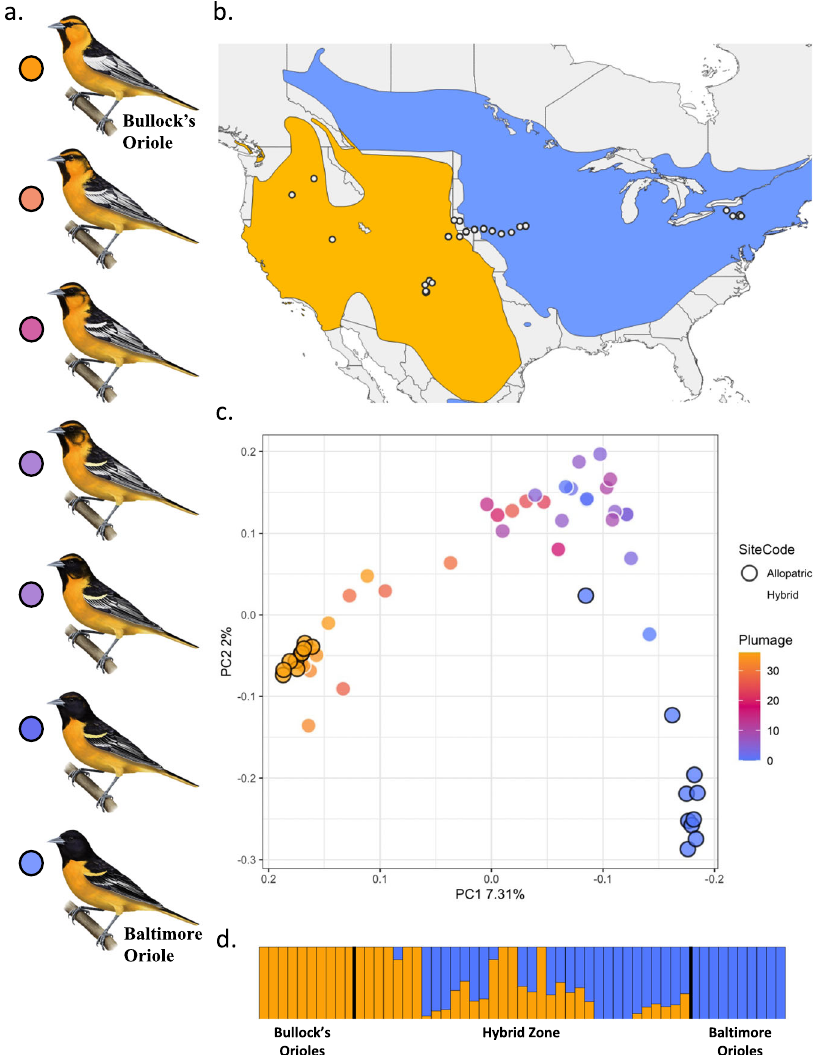
Fig. 1 Geographic, phenotypic, and genomic variation in Baltimore and Bullock ’ s orioles. a An example of the phenotypic gradient observed in the two species and their hybrids. Phenotypically pure Baltimore Orioles are in blue and phenotypically pure Bullock ’ s Orioles are in orange. Illustrations by Megan Bishop, 2019. This image is the property of Cornell University. b Sampling locations for the individuals sequenced for this study. The range of both the Bullock ’ s (orange) and the Baltimore (blue) oriole is shaded on the map. c PCA of 55 resequenced individuals based on 11.6 million SNPs. Individuals are colored by plumage score. Black circles indicate individuals sampled outside of the hybrid zone. d ADMIXTURE plot ( K = 2) for re-sequenced males. ADMIXTURE analyses were run using a fi ltered dataset (110,621 autosomal) that contained no missing data and was pruned to avoid